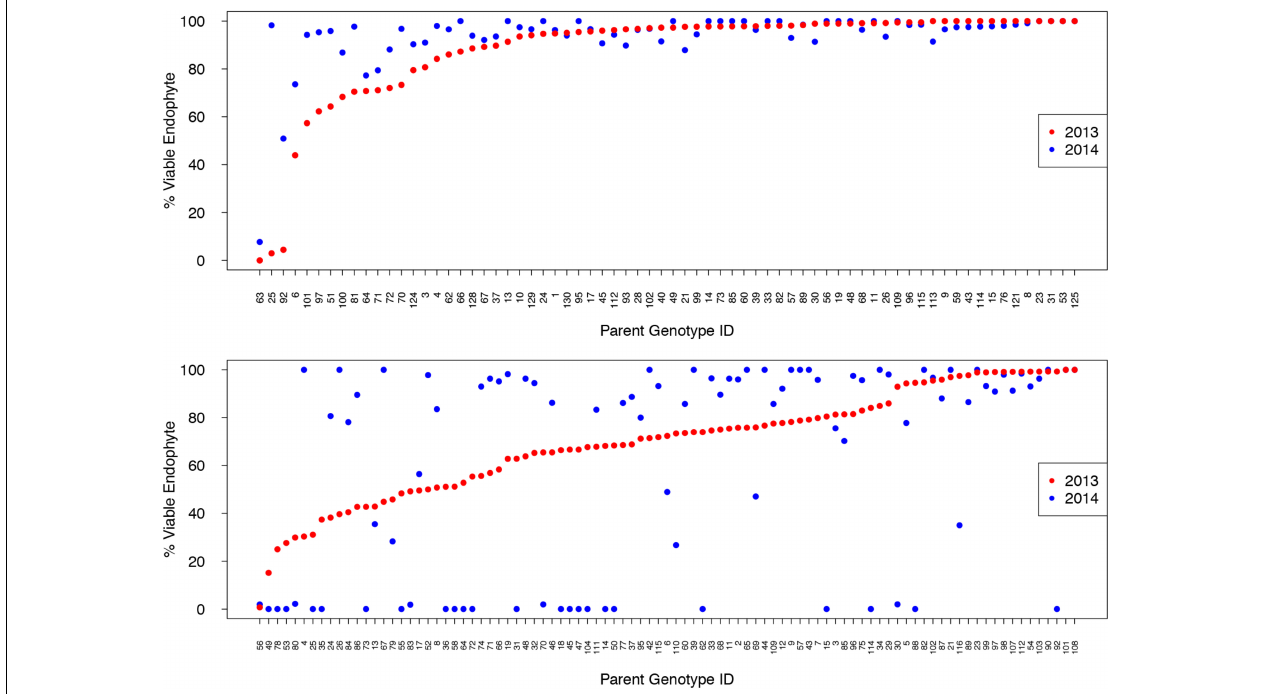
FIGURE 4 | The % viable endophyte transmission for Populations I (upper panel) and IV (lower) in 2013 and 2014, with genotypes ranked from lowest to highest based on 2013 data.